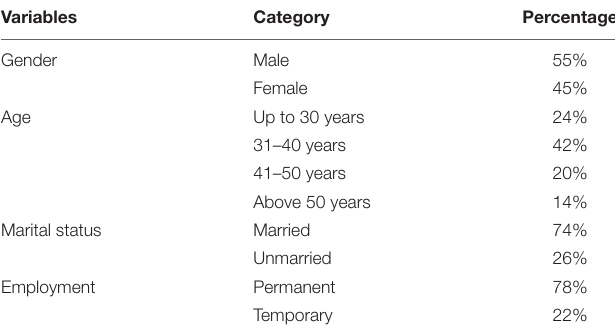
TABLE 1 | Demographic description of the